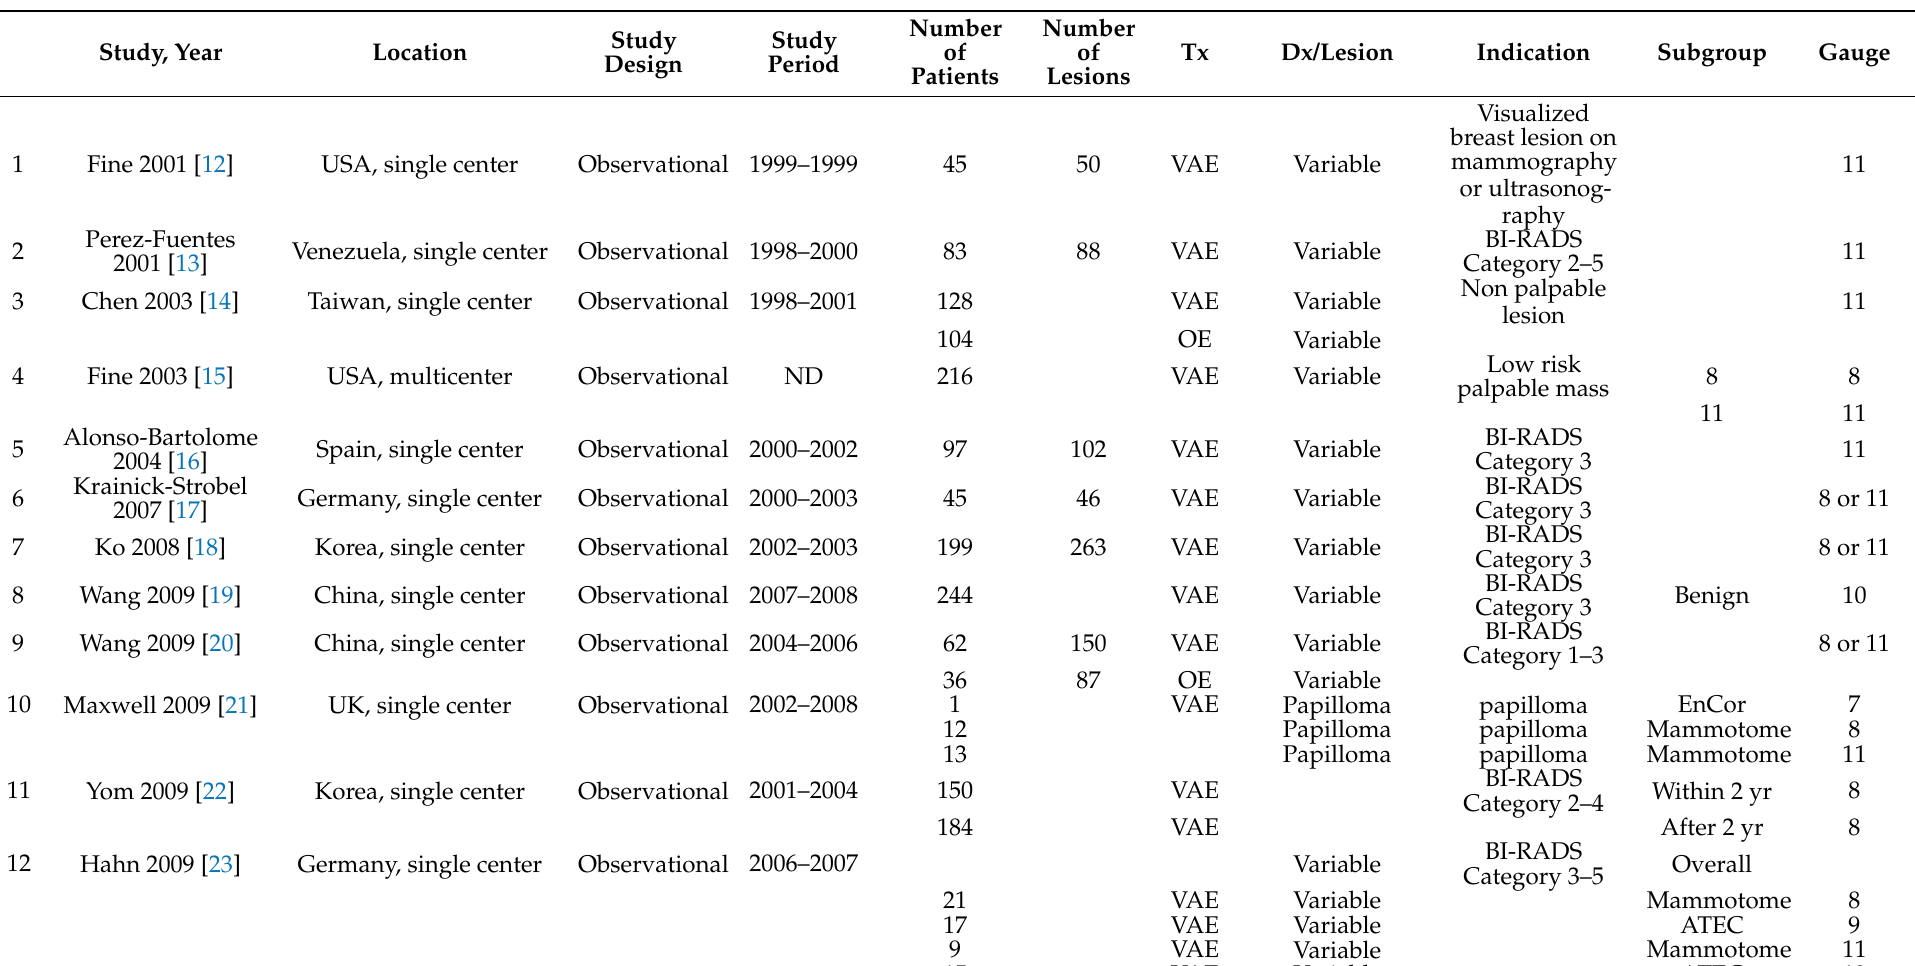
Table 1. Main characteristics of the eligible